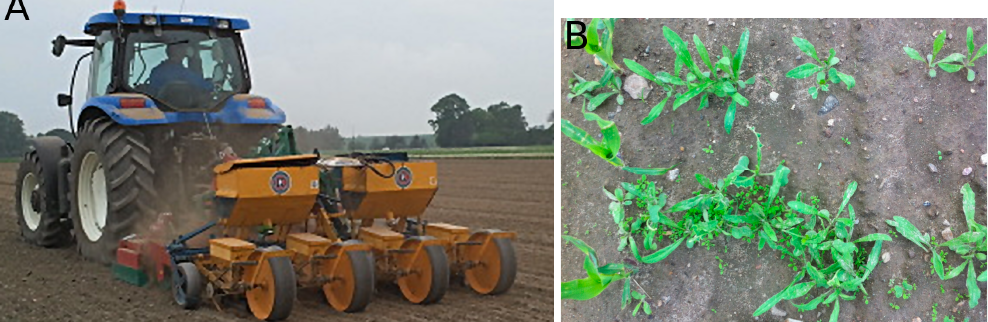
Figure 5. ( A ) 4 June 2013: Seeding the maize while logging the center of the seeding implement; ( B ) 27 June 2013: Unsprayed seeded weeds 23 days after